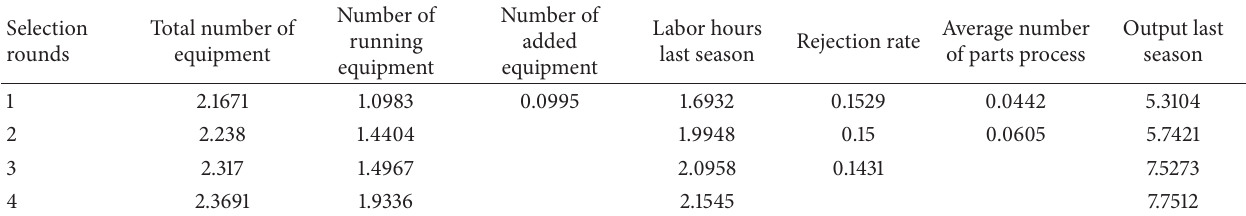
Table 2: t value in selection process.